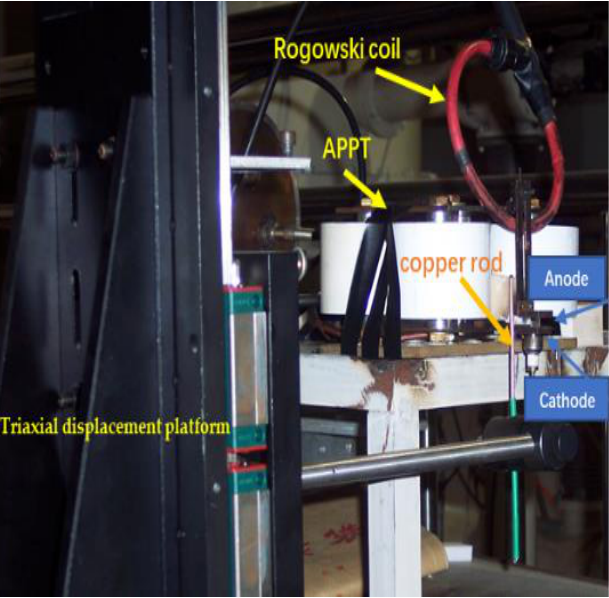
Figure 5. Inductance gradient measuring device diagram.